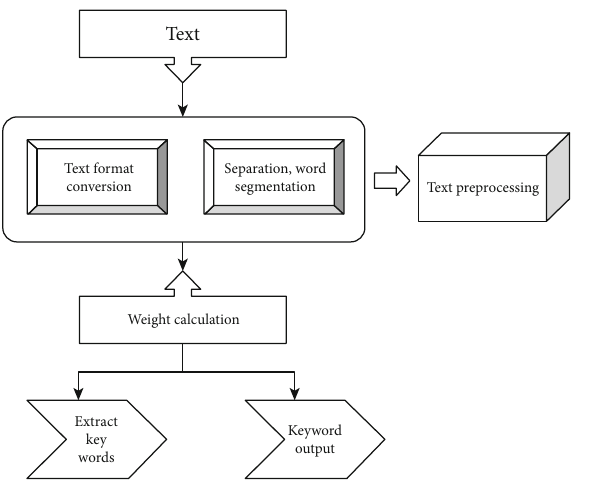
Figure 3: Process of extracting the relationship between subject entities and